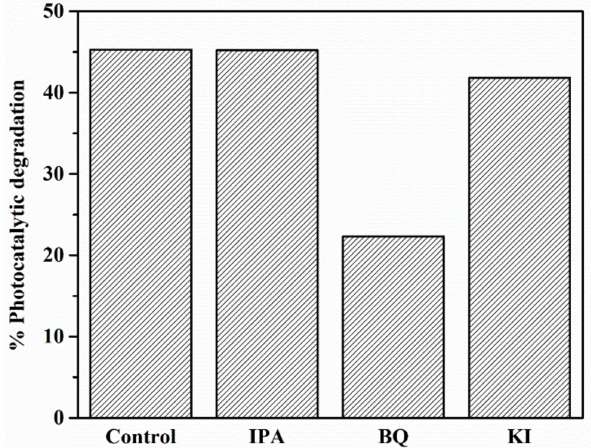
Figure 8. Photocatalytic degradation of RhB over sepiolite in the presence of different radical scavengers. IPA: isopropyl alcohol; BQ: benzoquinone; and KI: potassium iodide.